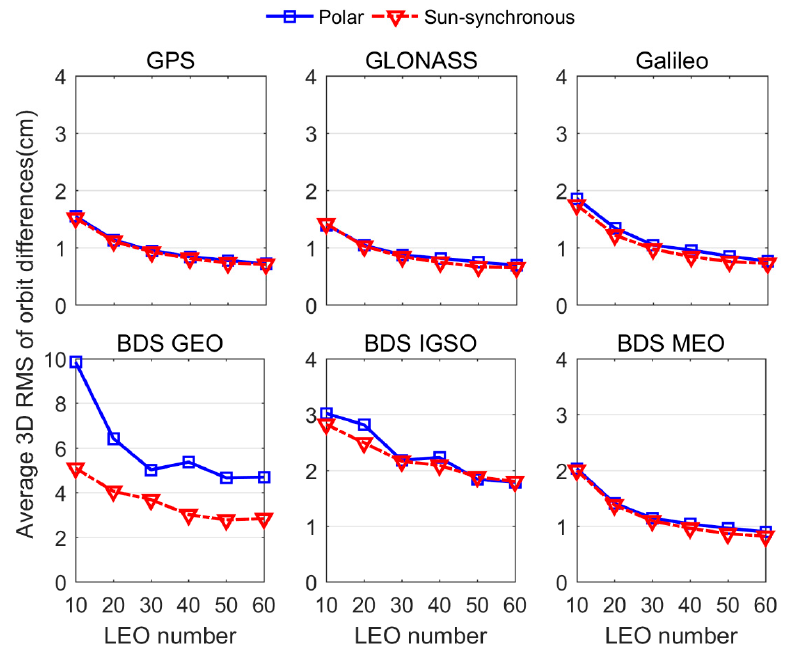
Figure 12. Average 3D RMS of GNSS orbit differences for the integrated POD with different numbers of LEO satellites.